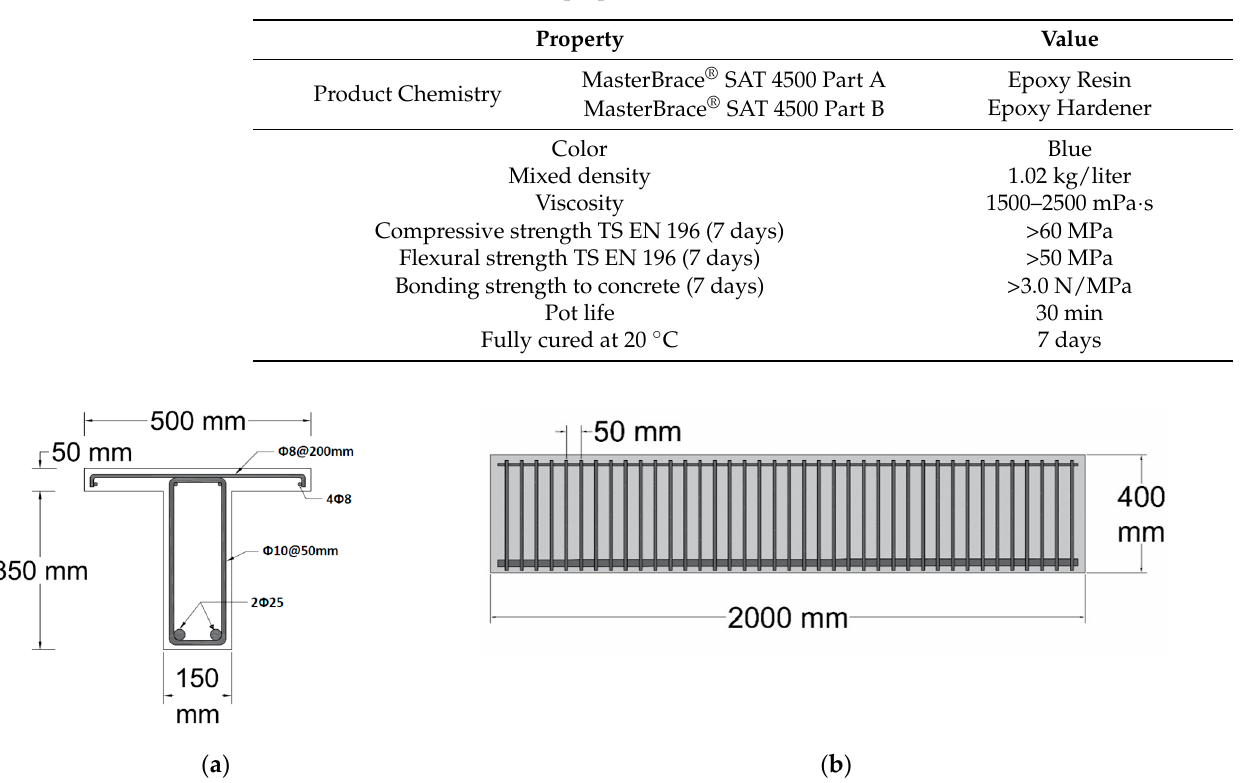
Table 6. MasterBrace SAT 4500 properties.